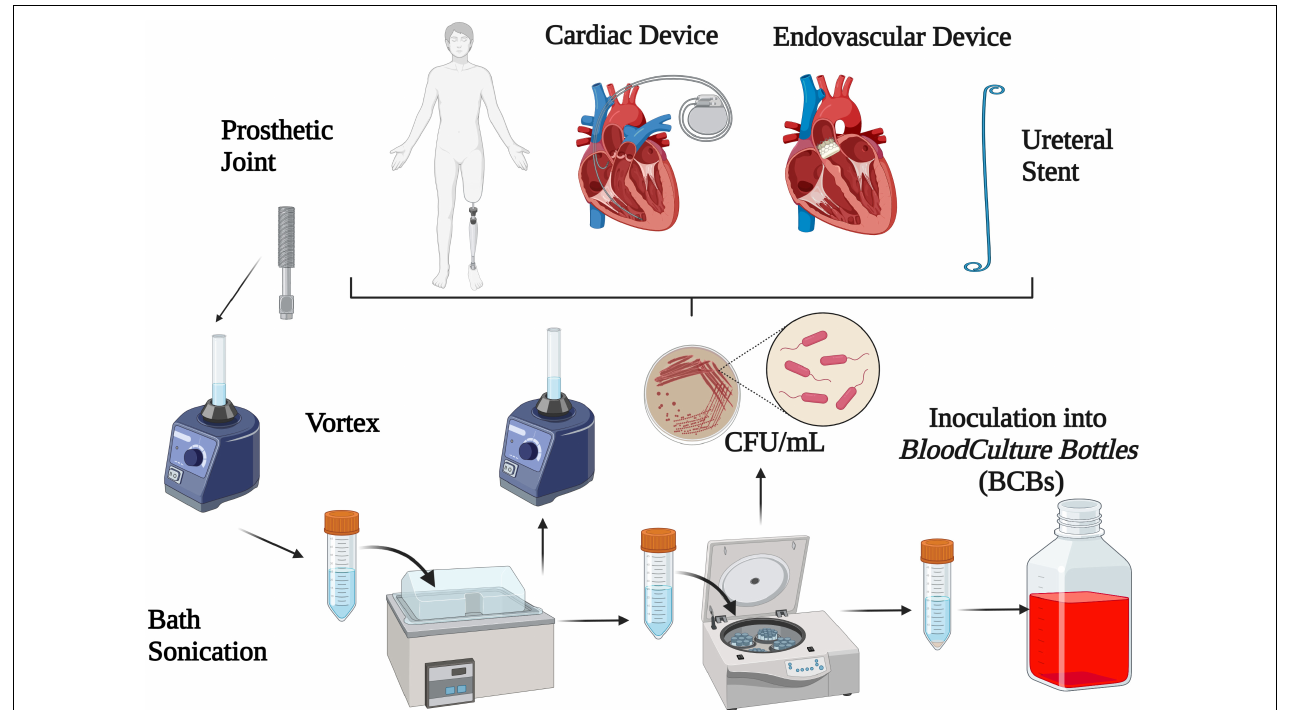
FIGURE 1 | Overview of sonication method for the diagnosis of implant-associated